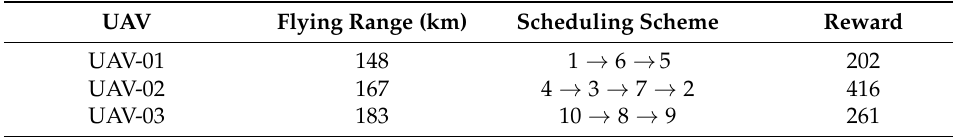
Table 8. Offline Task Scheduling Schemes.